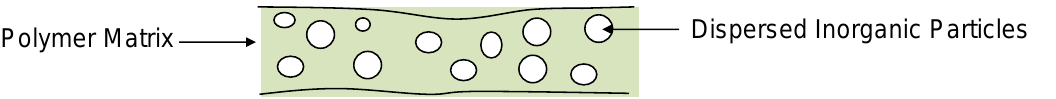
Figure 2. Schematic of a Mixed-Matrix Membrane.